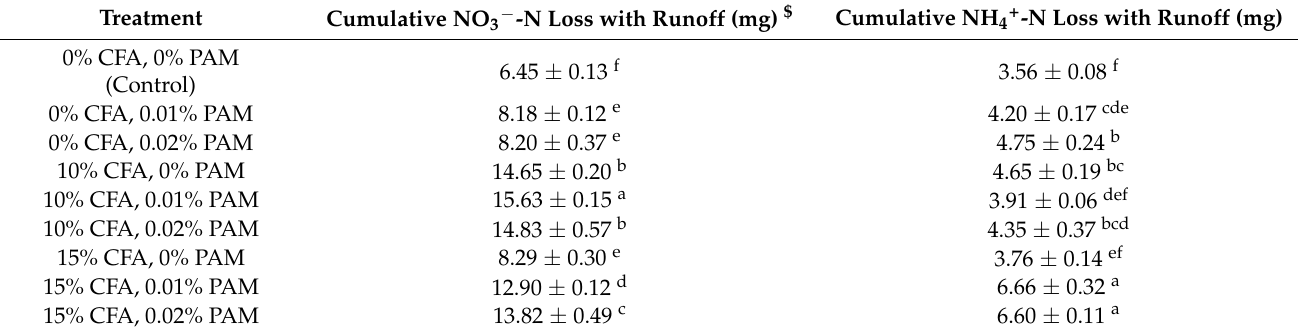
Table 1. Effect of CFA and PAM on runoff-associated cumulative NO 3 − -N and NH 4+ -N losses at the end of the rainfall event.